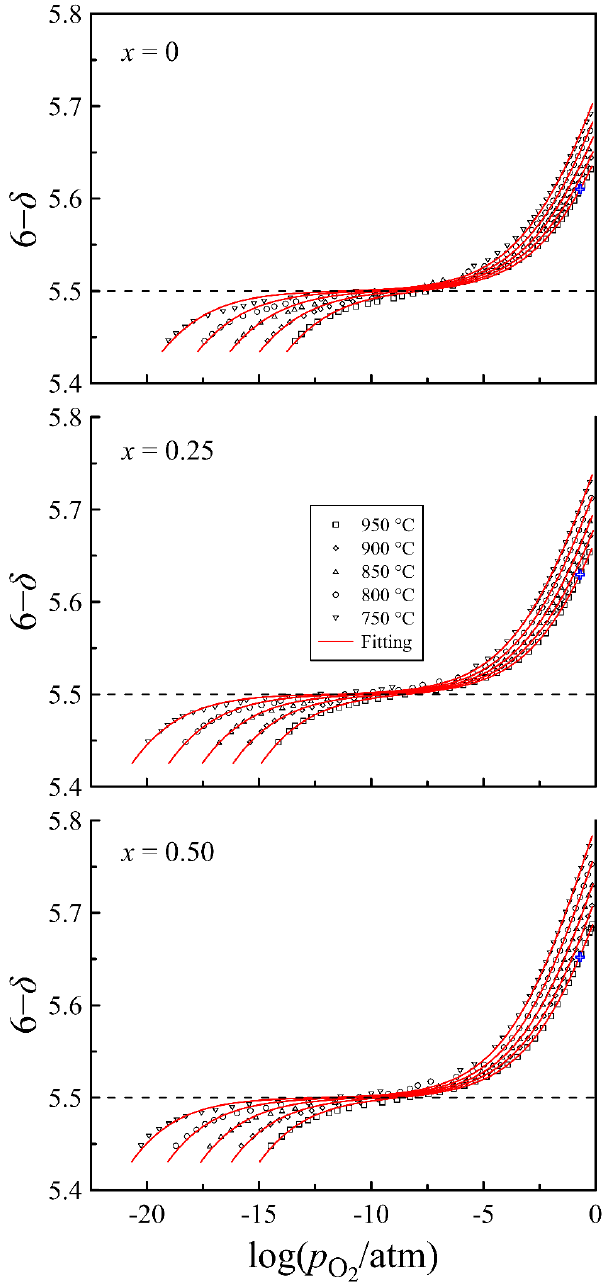
Figure 6. Oxygen content in PrBa 0.5 Sr 0.5 Fe 2 O 6− δ as a function of oxygen partial pressure at different temperatures. Dashed lines indicate the oxygen content corresponding to the nominal iron oxidation state in 3+ oxides. Solid lines represent the results of the model calculation. The cross-like symbols designate oxygen content at p O = 0.21 atm and 950 ◦